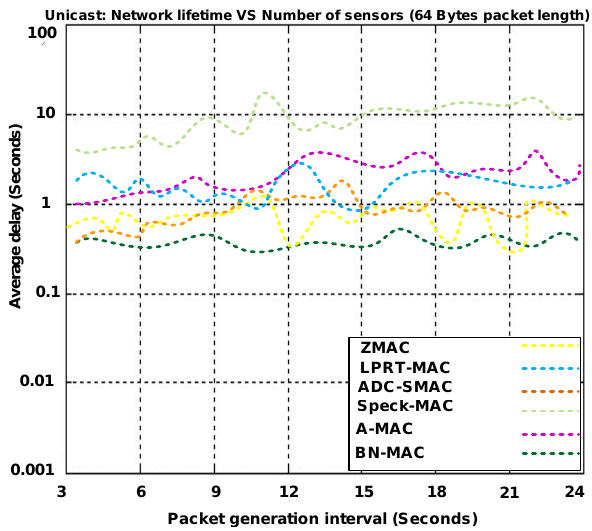
Figure 17. Average packet delay at different intervals.